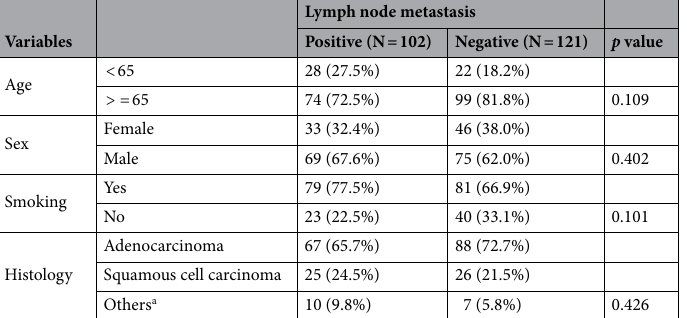
Table 1. Relationship between lymph node metastasis and clinical features in 223 patients with lung cancer. a Others, adenosquamous cell carcinoma, large cell carcinoma, small cell carcinoma, pleomorphic carcinoma, and mucoepidermoid